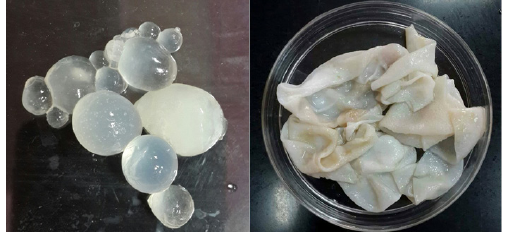
Fig. 4. living protoscolices (green) and dead protoscolices (red) used eosin stain